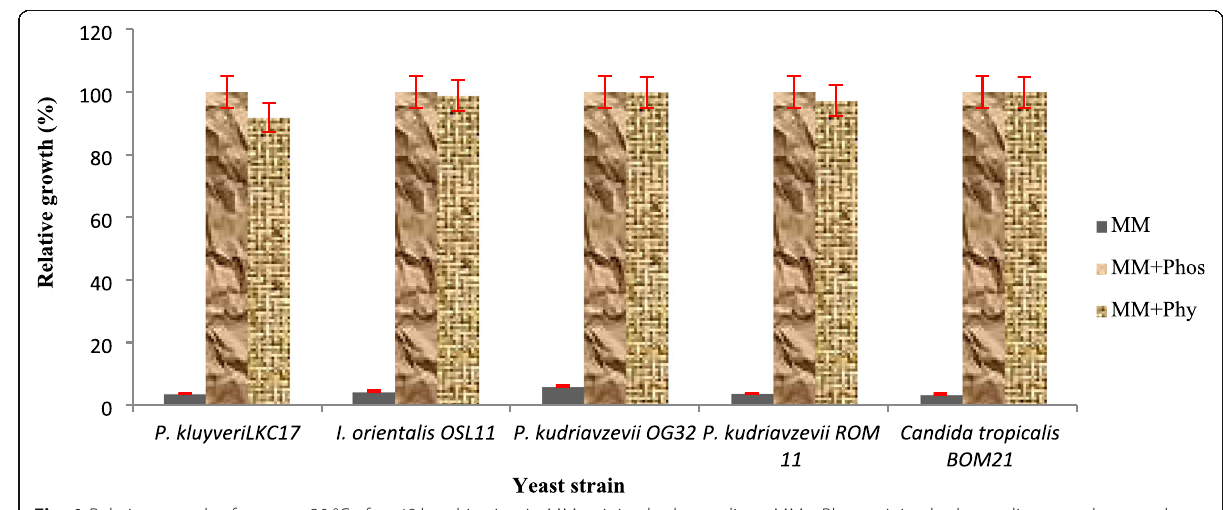
Fig. 1 Relative growth of yeast at 30 °C after 48 h cultivation in MM, minimal salts medium; MM+ Phos, minimal salts medium supplemented with 3 g L − 1 potassium dihydrogen phosphate (KH 2 PO 4 ); MM+ Phy, minimal salts medium supplemented with 3 g L − 1 sodium